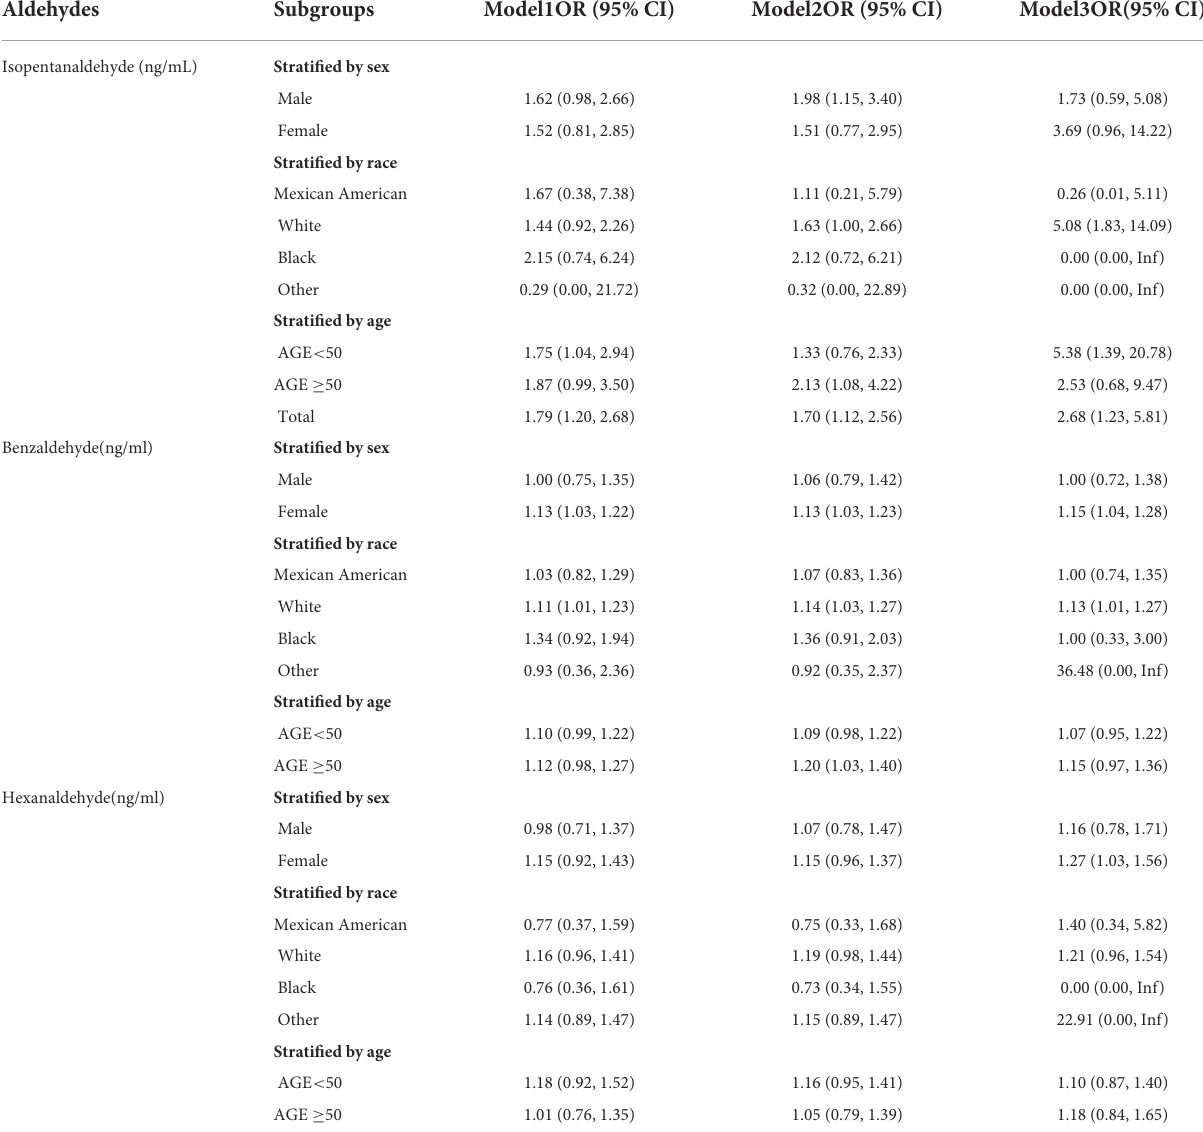
TABLE 3 Subgroup analysis between three aldehydes and kidney stones. Aldehydes Subgroups Isopentanaldehyde